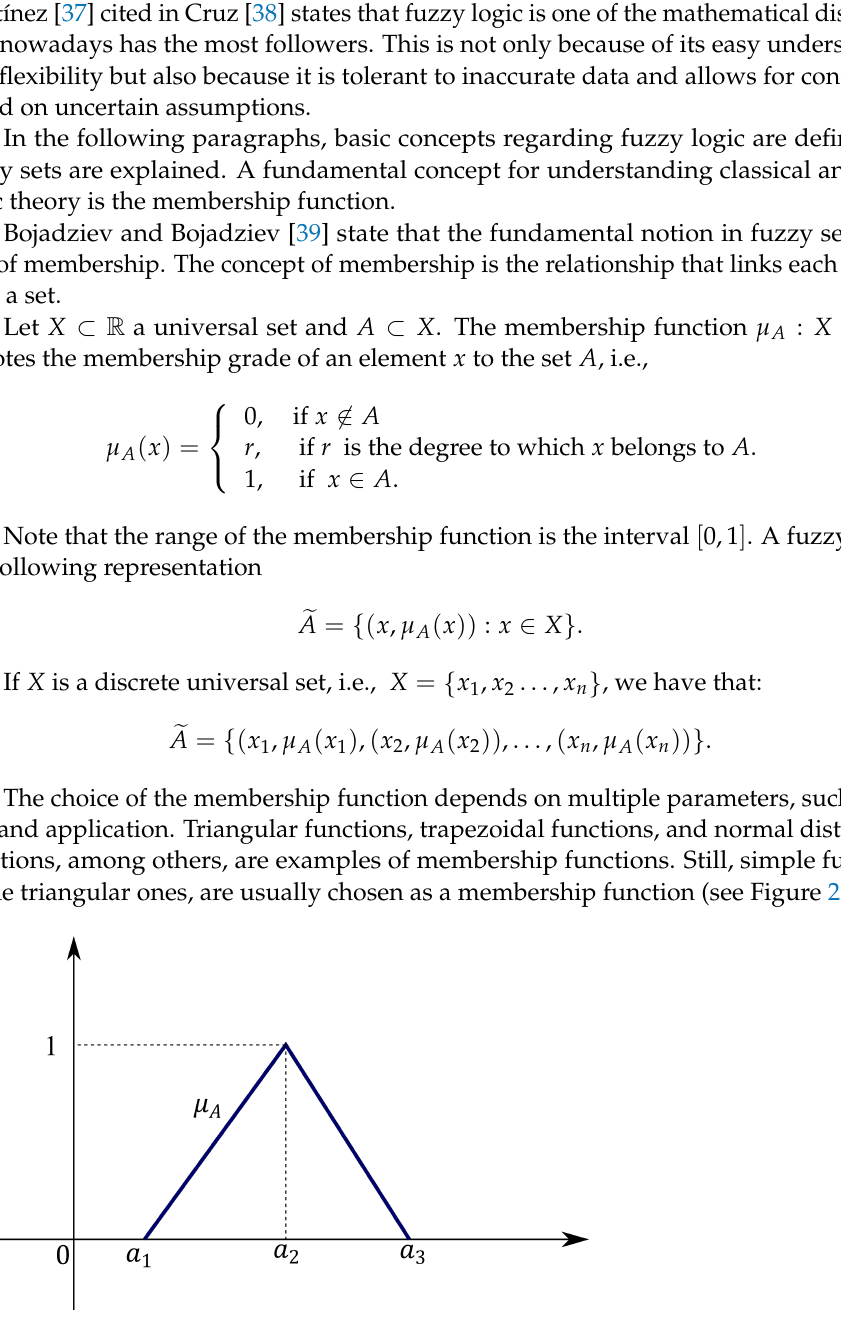
Figure 2. Membership function µ A